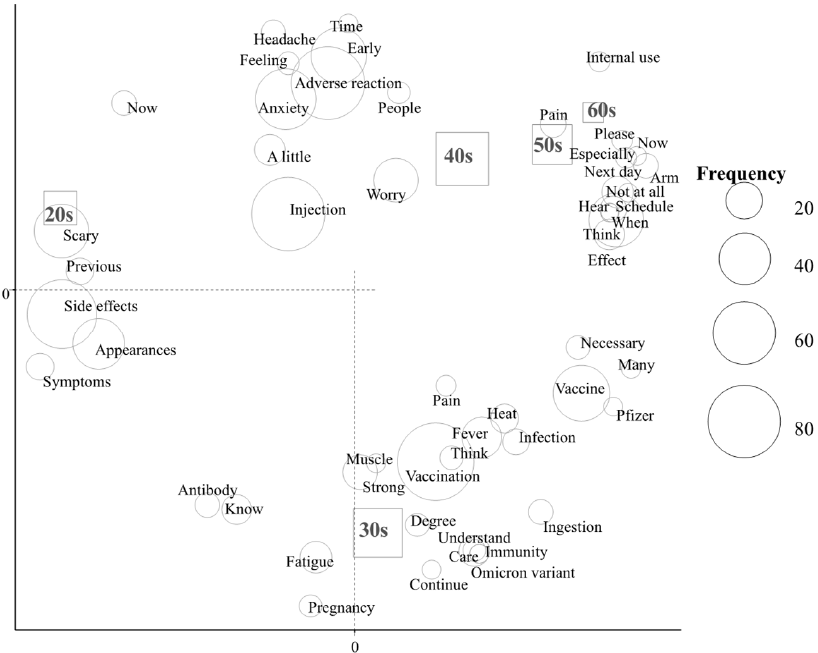
Figure 1. Correspondence analysis of the relationship between frequently used words and age.